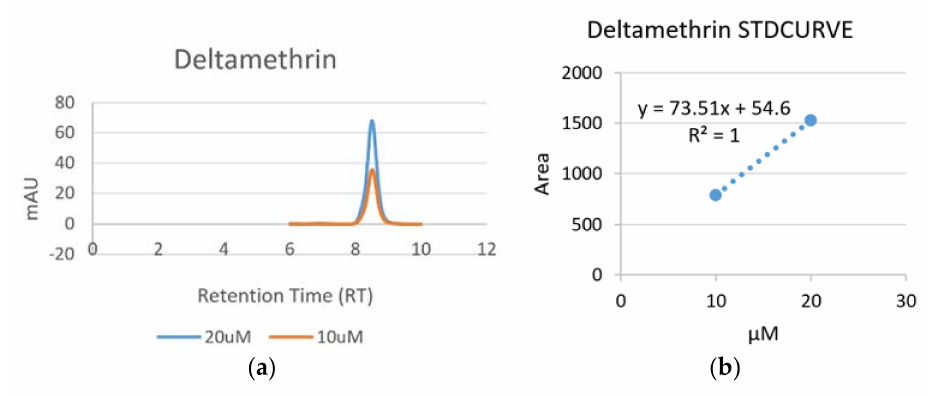
Figure 2. Chromatogram ( a ) and standard curve ( b ) of Deltamethrin.